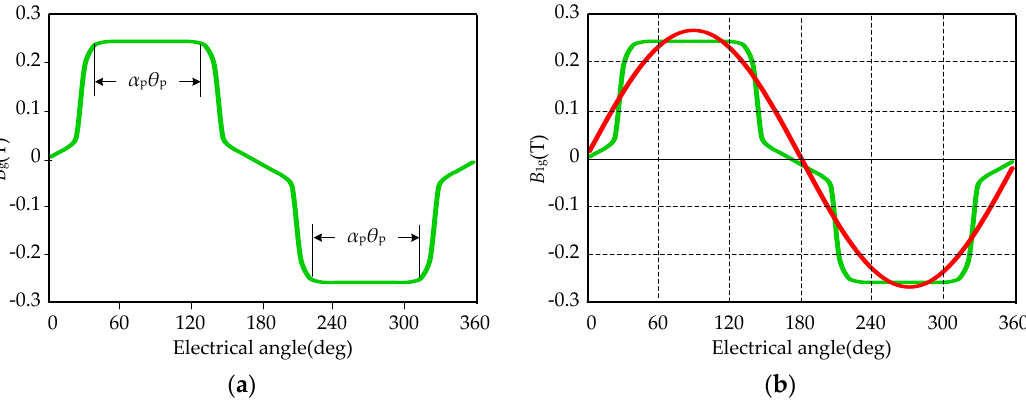
Figure 4. The air gap flux density waveform under a pair of poles of conventional surface mounted pole structure and its fundamental component: ( a ) The air gap flux density; ( b ) The fundamental component of the air gap flux density.